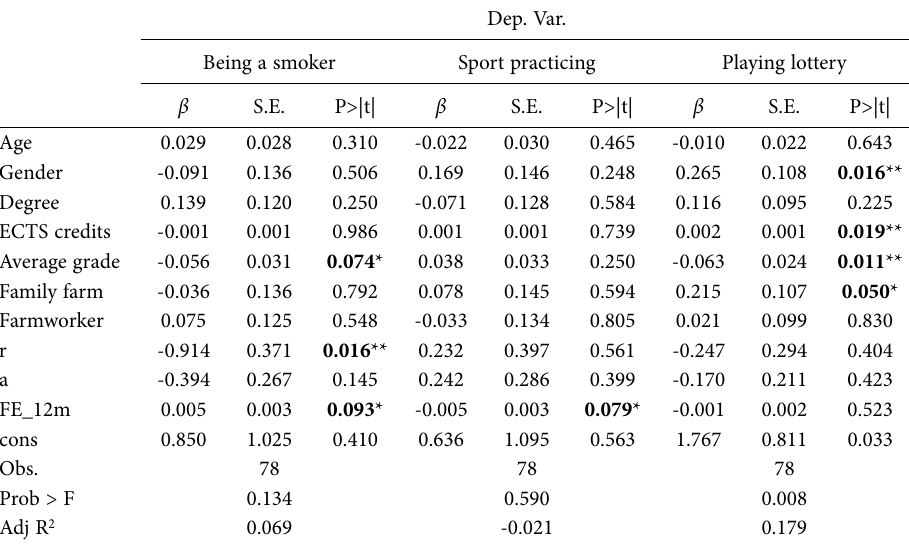
Table 5. OLS Estimates on being a smoker, sport practicing, and playing lottery.